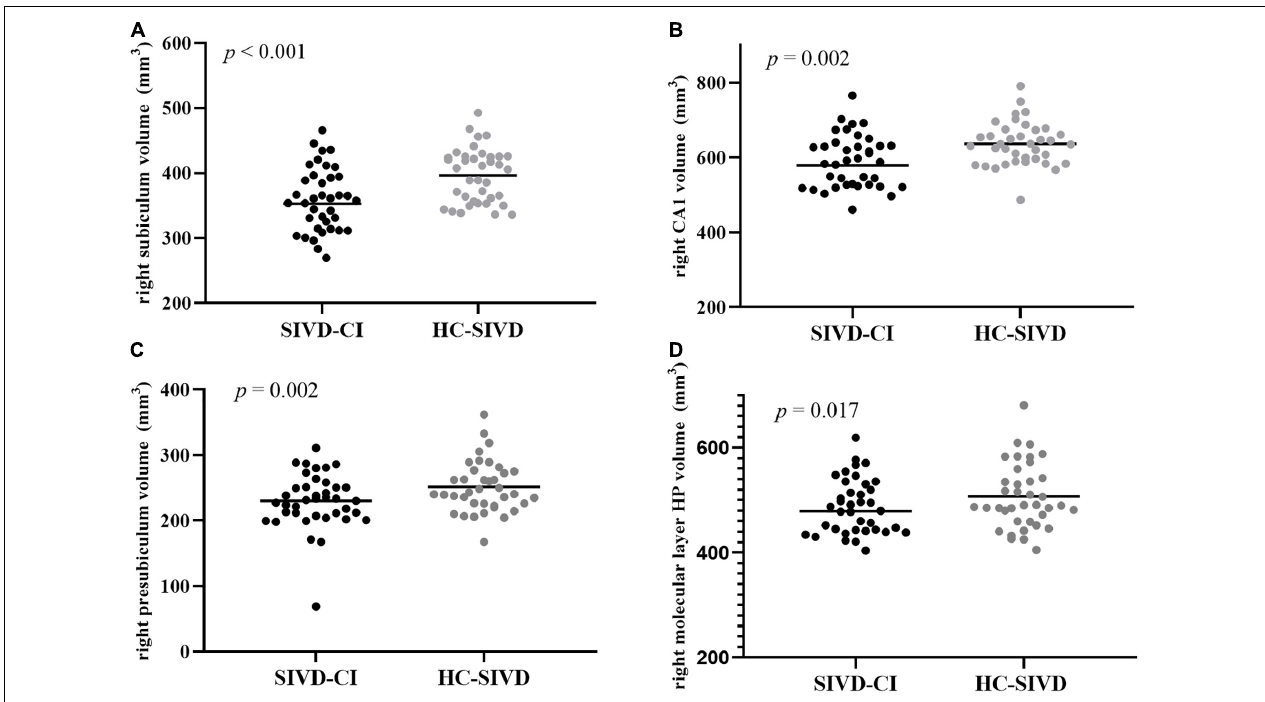
FIGURE 3 | Differences between the SIVD-CI and HC-SIVD groups of hippocampal subfield volumes in the right subiculum (A) , right CA1 (B) , right presubiculum (C) , and right molecular layer HP (D) . CA, cornus ammonis. TABLE 5 | Correlations between memory scores and hippocampal subfield volumes with intergroup differences in SIVD patients. Right subiculum Right CA1 Right presubiculum Right molecular layer